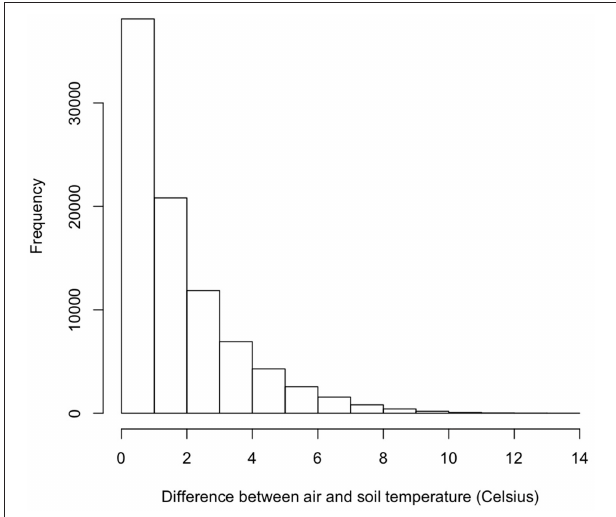
FIGURE 2 | Histogram of differences between simulated air and soil temperature.